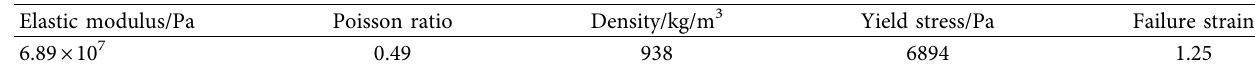
Table 11: Parameters of plastic kinematic model.